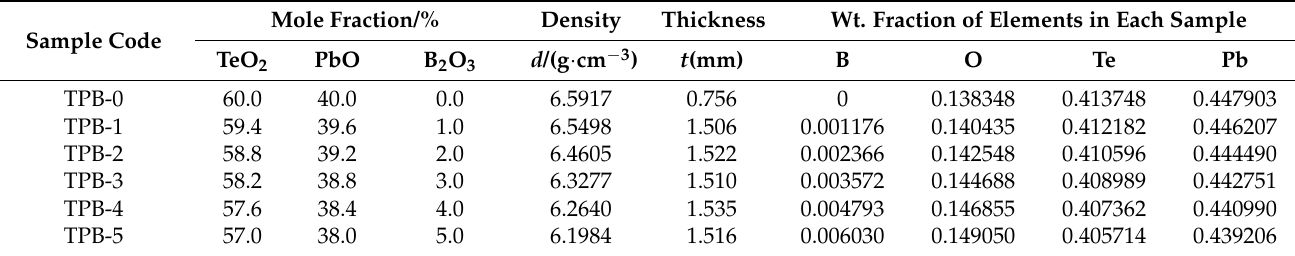
Table 1. Compositions, density, and thickness of glass